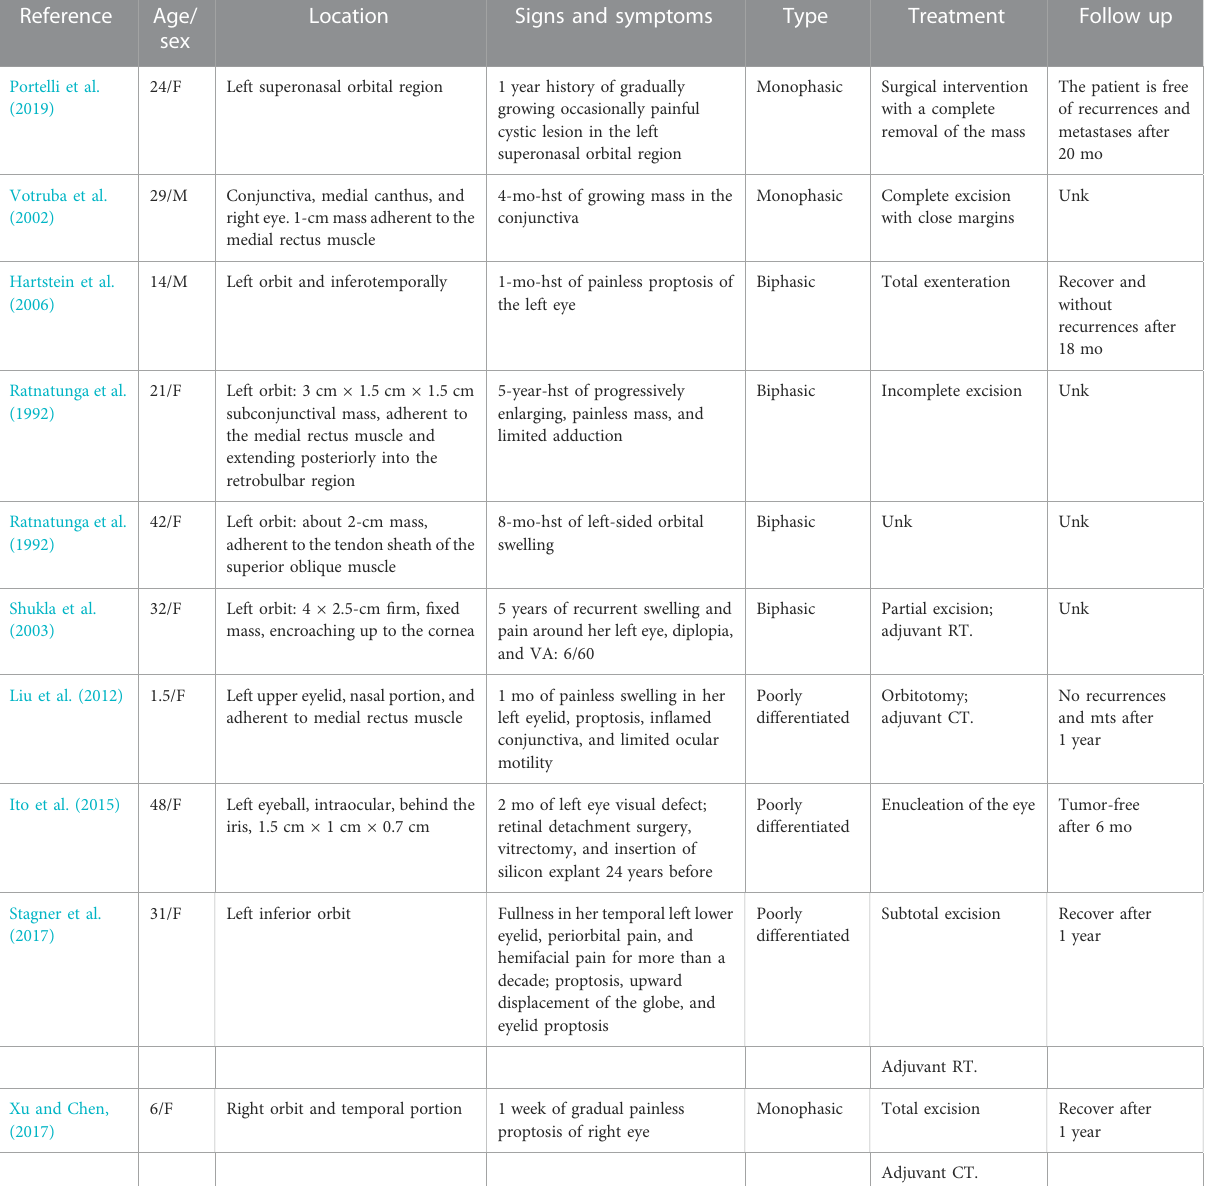
TABLE 4 Reported cases of synovial sarcoma of the orbital and ocular